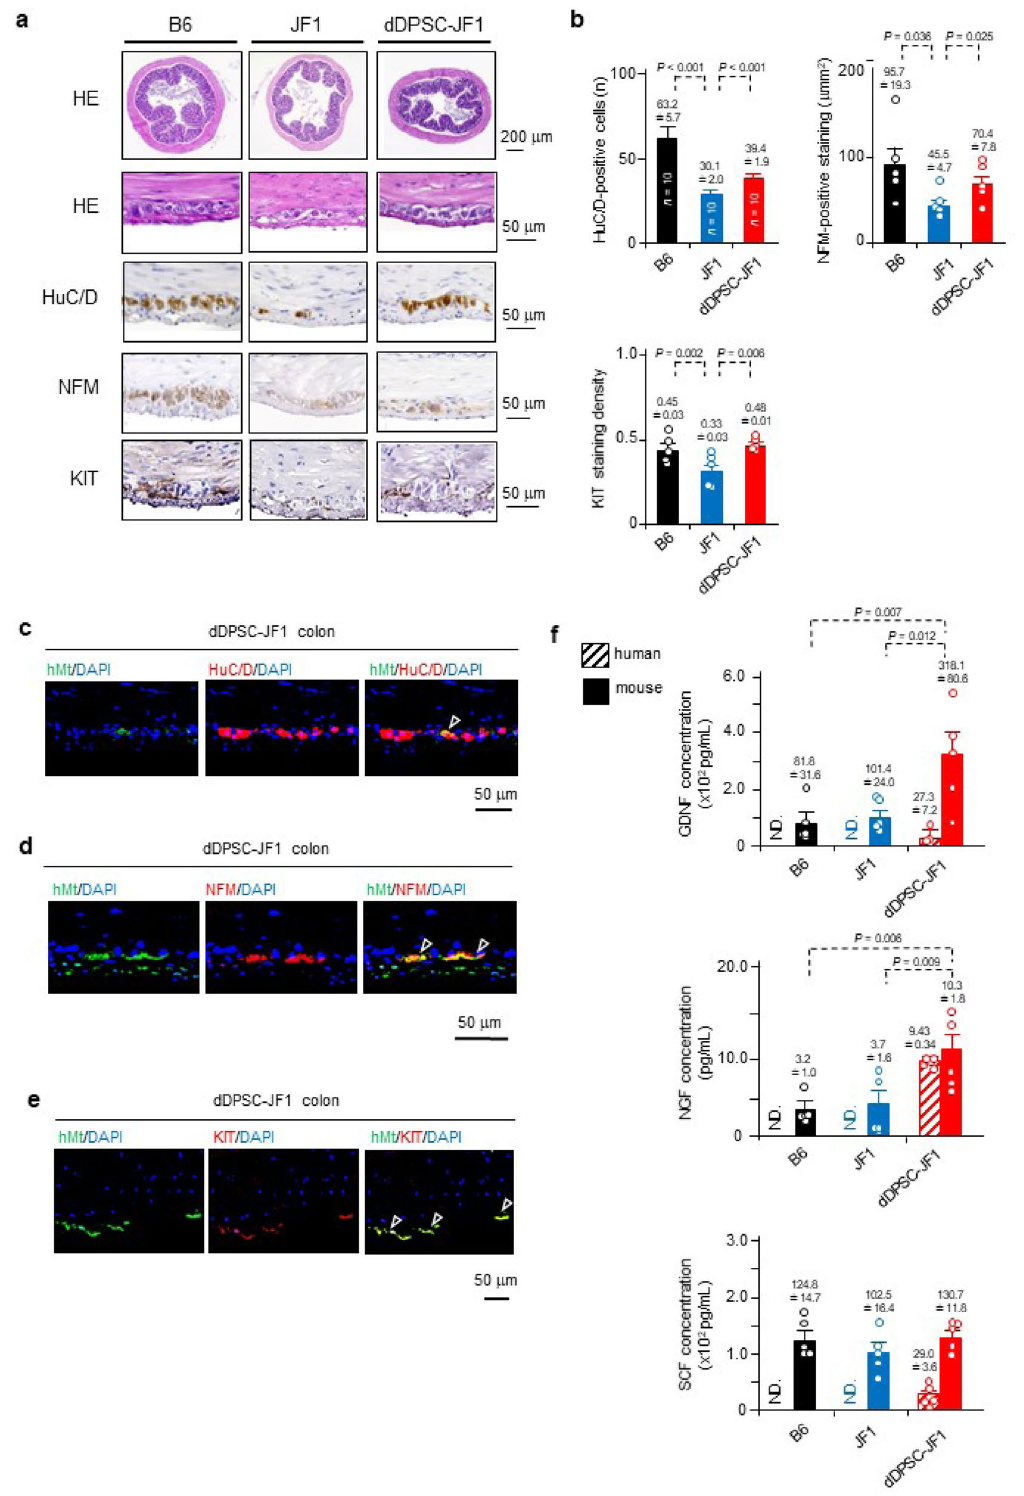
Figure 2. Differentiation of transplanted dDPSCs. ( a ) Proximal colon sections stained with haematoxylin–eosin (upper: × 40; lower: × 400) or immunostained for HuC/D (neuron-specific marker; × 400), NFM (peripheral ganglion marker; × 200) or KIT (pacemaker interstitial cell marker; × 200). ( b ) Number of HuC/D-positive cells per tissue cross-section (mean ± SEM, n = 10), NFM-positive area in the myenteric plexus (mean ± SEM, n = 5), and KIT-positive staining density in the proximal colon (mean ± SEM, n = 5). ( c–e ) Immunostaining for hMt, HuC/D, NFM and KIT (nuclei counterstained with DAPI). Arrowheads: dDPSC-derived cells. ( f ) Human and mouse NGF, GDNF and SCF concentrations (mean ± SEM, n = 5). ND, not detected. ( a,c–e ) Representative of ≥ 2 independent